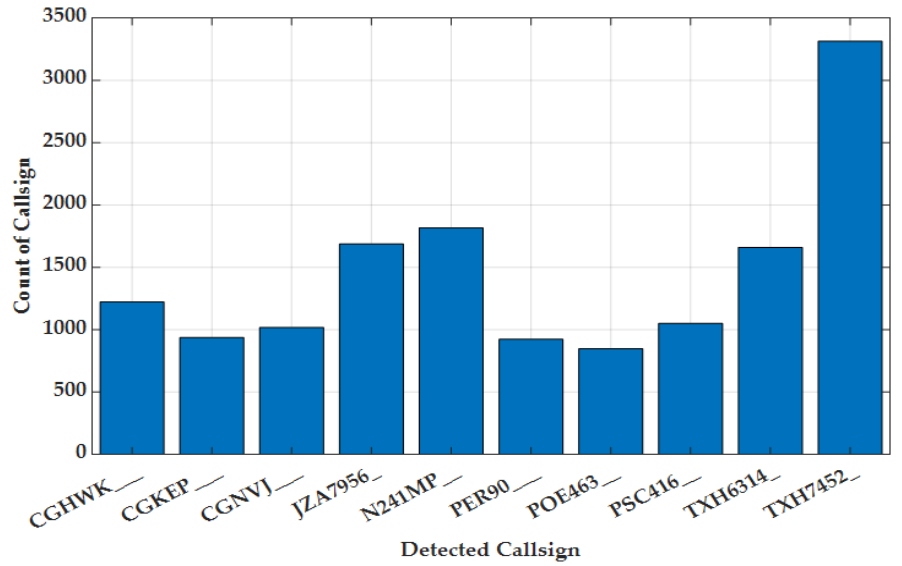
Figure 16. Count of top 10 detected callsigns during flight test.